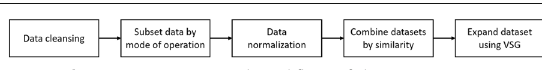
Fig. 2 (Abstract P2). Proposed workflow of the preprocessing step for machine learning model